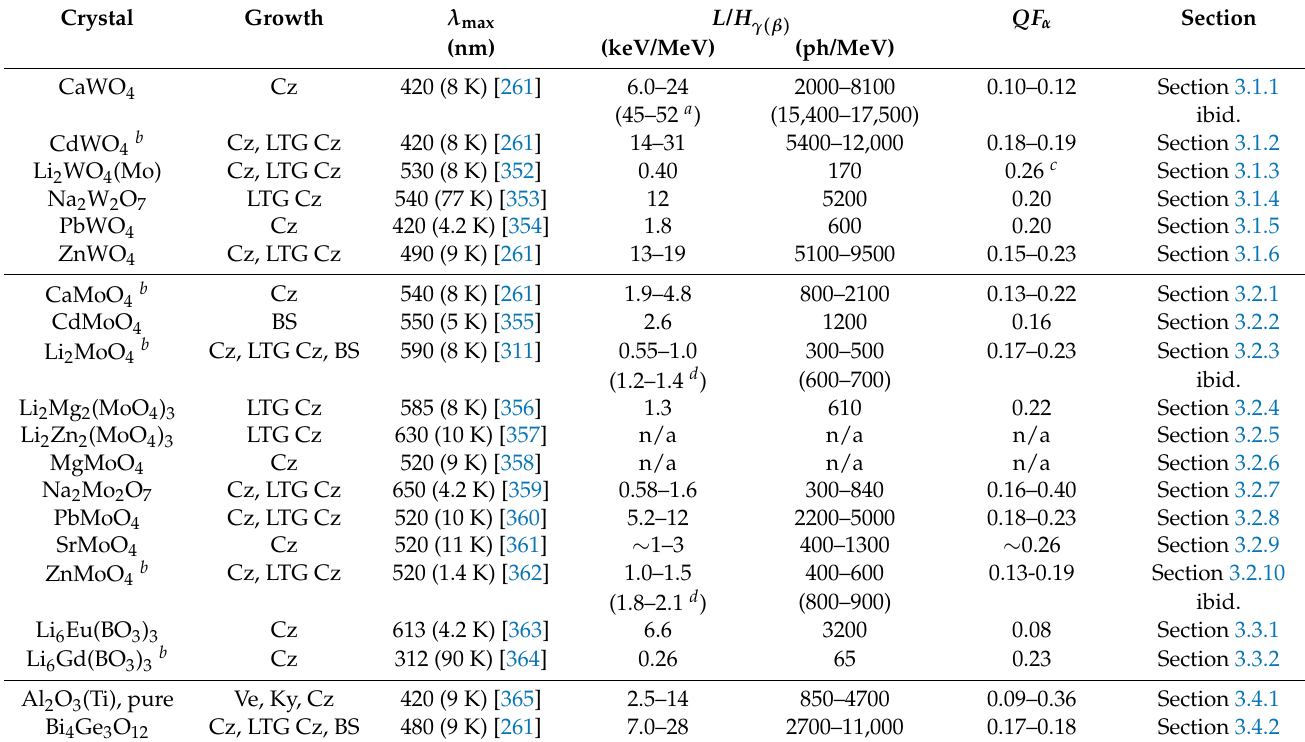
Table 3. Scintillation properties of inorganic materials used in low-temperature particle detectors with simultaneous phonon and scintillation readout. Crystal growth method(s), wavelength of the emission peak ( λ max ) of the material at the quoted temperature, light-to-heat ratio for γ ( β ) ’s, L / H γ ( β ) , scintillation light quenching for α particles, QF α , with respect to γ ( β ) s are listed. Typically used crystal growth processes are the following [348–351]: ordinary and low-temperature-gradient Czochralski (Cz and LTG Cz, respectively), Kyropoulos (Ky), Verneuil (Ve), and variations of Bridgman–Stockbarger (BS) techniques. The L / H γ ( β ) is evaluated in photons per MeV (ph/MeV) using the energy of photons corresponding to λ max .